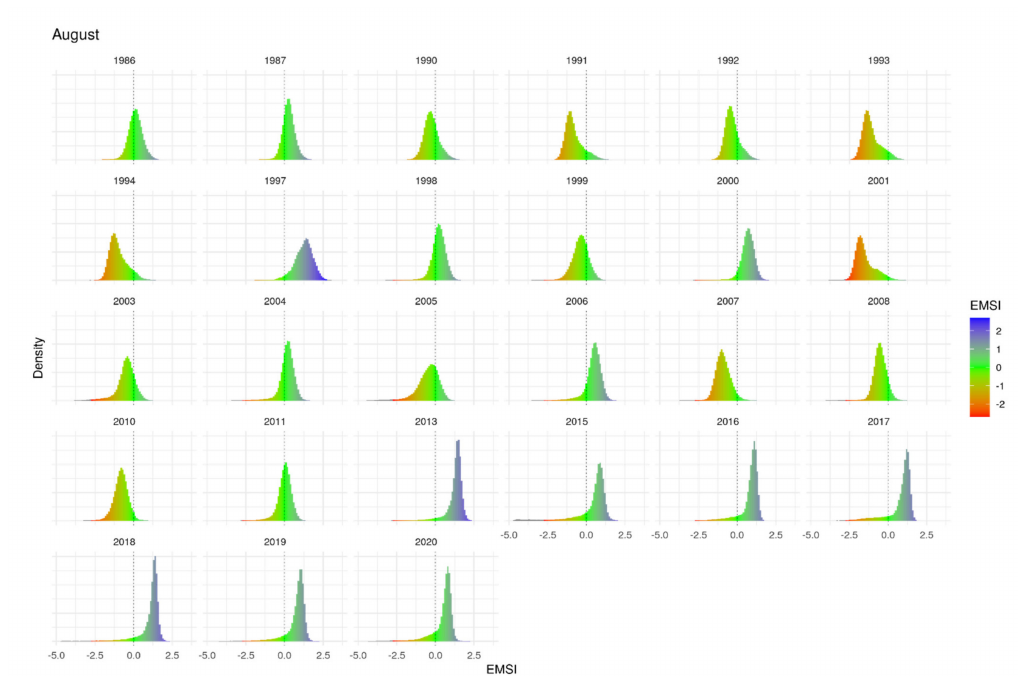
Figure A7. Histograms of the raster pixel distributions for EMSI across the entire time series for Acre Brazil with the reference period set over 34-years (eight years are absent due to lack of clear sky scenes). Years with deeper departures from normal are exemplified by redder or bluer means. Note, the increasing agricultural area extents result in an increase in negative values over time which are evidenced by a left tail.